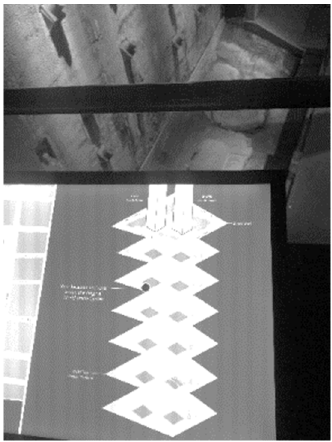
Figure 6. An exhibit with a reference map to the bombing site at the 9/11 memorial site.